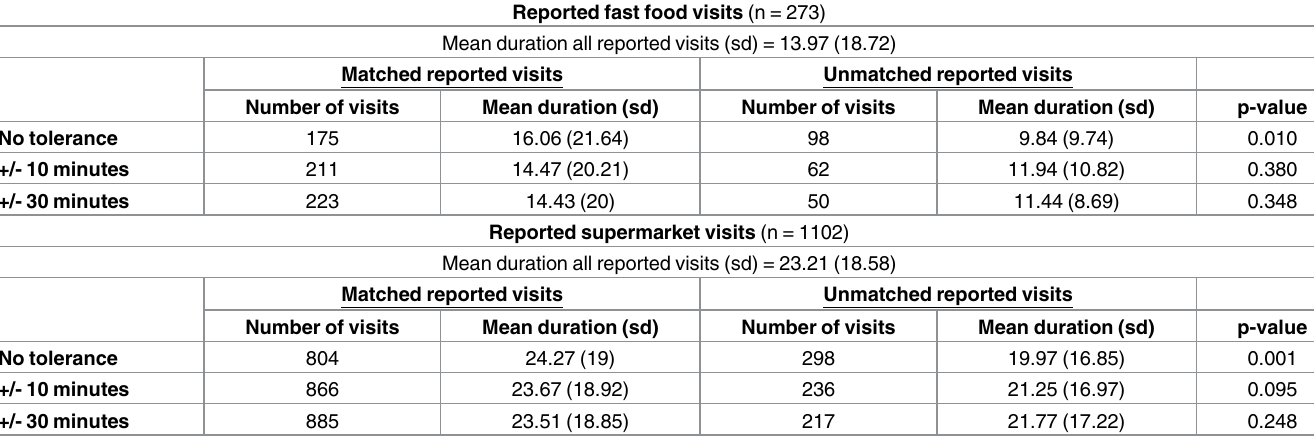
Table 4. Reported visit durations in minutes for GPS-sensed and unsensed food establishment